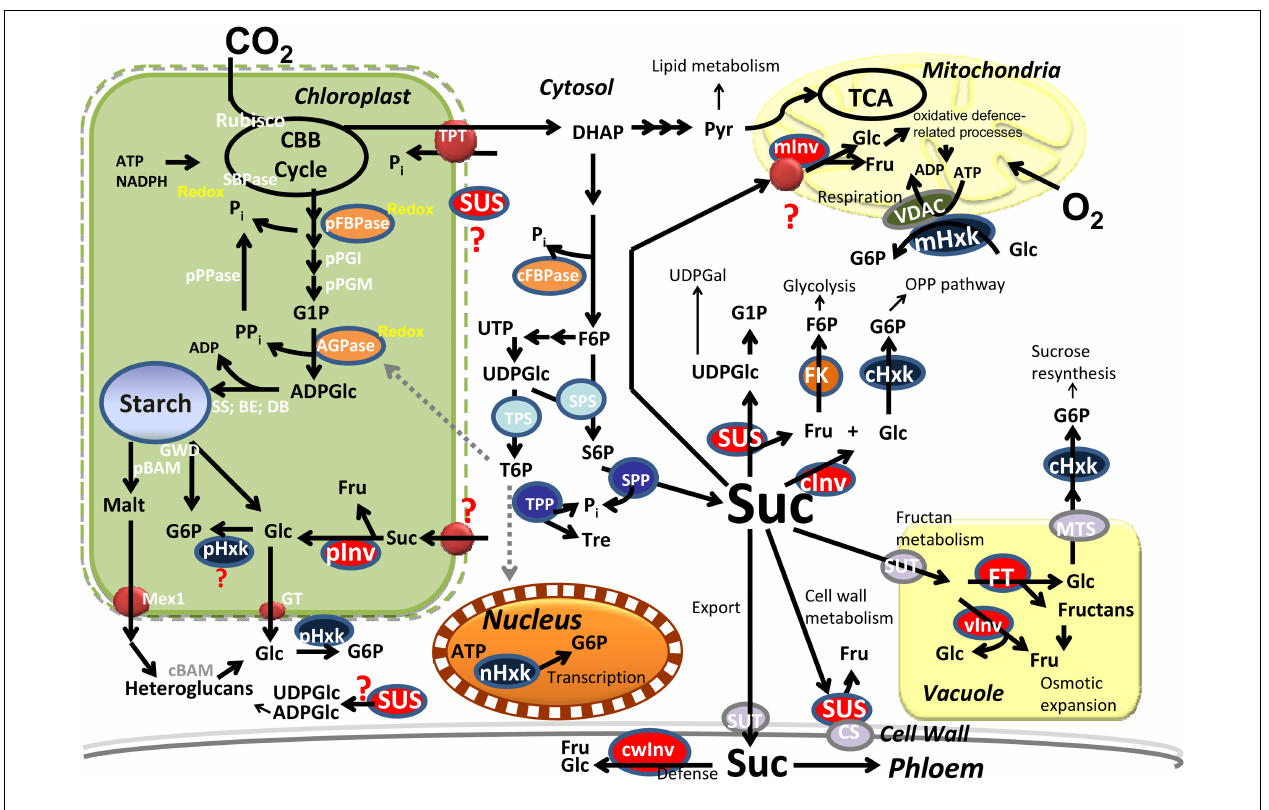
glucose transporter; GWD, glucan water dikinase; cHxk, mHxk, nHxk, pHxk, cytosolic, mitochondrial, nuclear, and plastidial hexokinase; cInv, cwInv, pInv, vInv, cytosolic, cell wall, plastidial, and vacuolar invertase; Malt, maltose; Mex1, maltose exporter; Pi, inorganic phosphate; PPi, pyrophosphate; Pyr, pyruvate; S6P, sucrose-6-P; SBPase, sedoheptulose-1,7-bisphosphate phosphatase; SPP, sucrose-6-P phosphatase; SPS, sucrose-6-P synthase; SS, starch synthase; SUS, sucrose synthase; SUT, sucrose transporter;Tre, trehalose;T6P, trehalose-6-phosphate; TCA, tricarboxylic acid cycle;TPP, trehalose-6-P phosphatase;TPT, triose-P translocator;VDAC, voltage-dependent anion